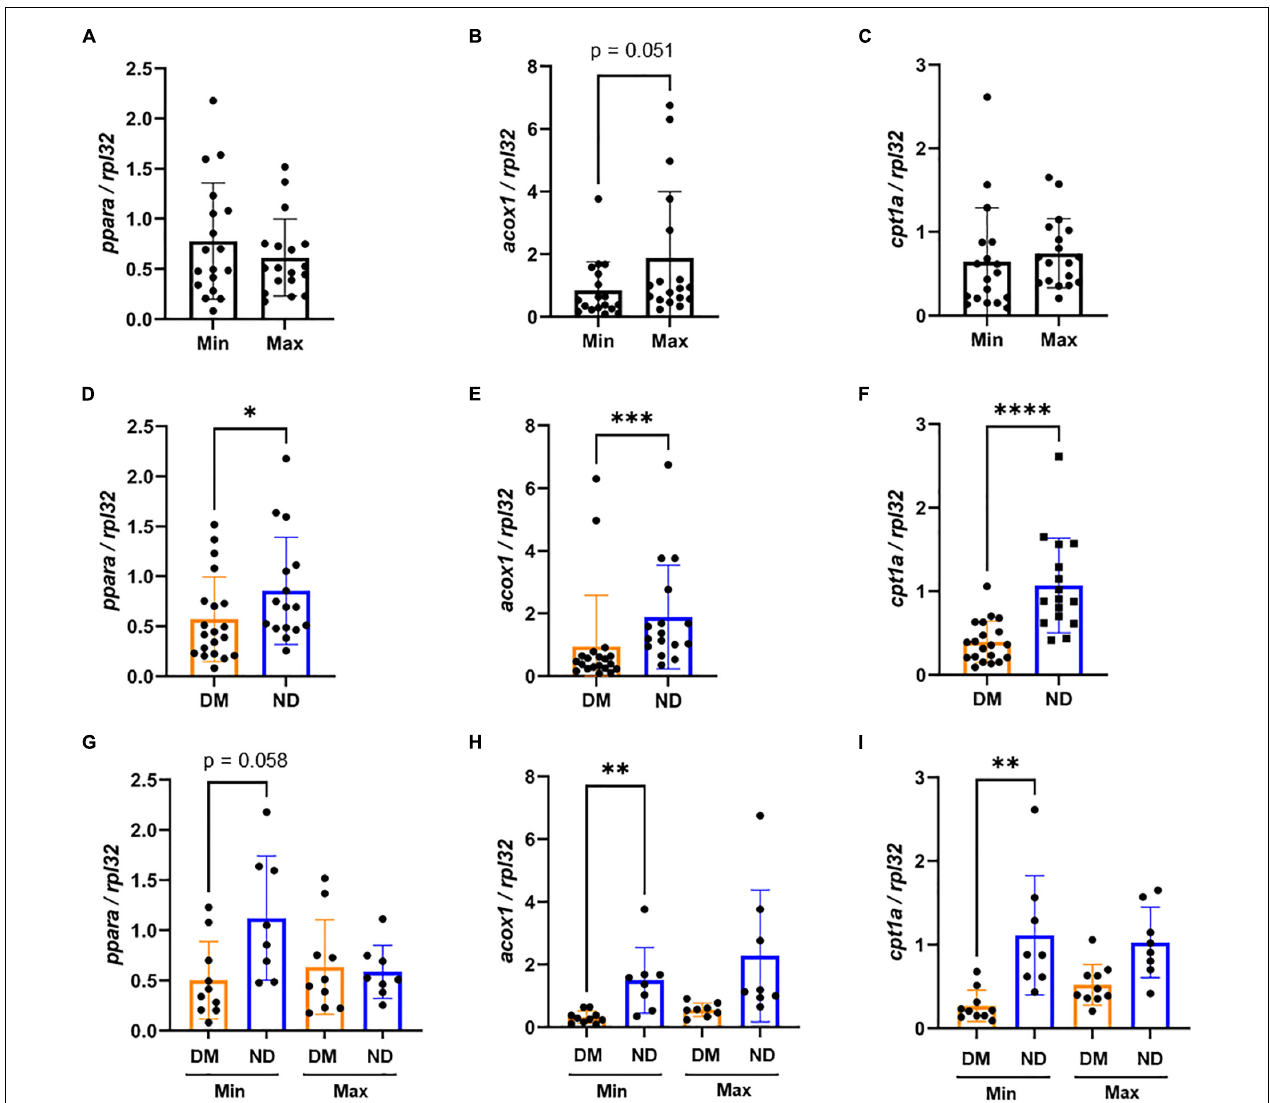
FIGURE 5 | mRNA expression variability of lower extremity segments by lesion severity and diabetic status: (A–C) In Lower extremity samples, we observed no significant difference in ppara and cpt1a mRNA expression between Min ( n = 18) and Max ( n = 18) diseased segments. However, we found Min-diseased samples had non-significantly lower expression of acox1 ( p = 0.051, n = 18) compared to Max-diseased. (D–F) We found that patients with diabetes ( n = 20) demonstrated significantly lower ppara ( p < 0.05), acox1 ( p < 0.001) and cpt1a ( p < 0.0001) mRNA expression compared to patients without diabetes ( n = 16). (G–I) When categorizing segments between diseased and diabetic status, we observed no significant variability of ppara . However, we found a significant decrease of acox1 ( p < 0.01) and cpt1a ( p < 0.01) in patients with diabetes ( n = 10) compared to patients without diabetes ( n = 8) from Min-diseased tissues. DM, Diabetic. ND, Non-diabetic. Min, minimally diseased. Max, maximally diseased. Data are presented as Mean ± SD and, each point represents one patient sample. ∗ p < 0.05, ∗∗ p < 0.01, and ∗∗∗ p <